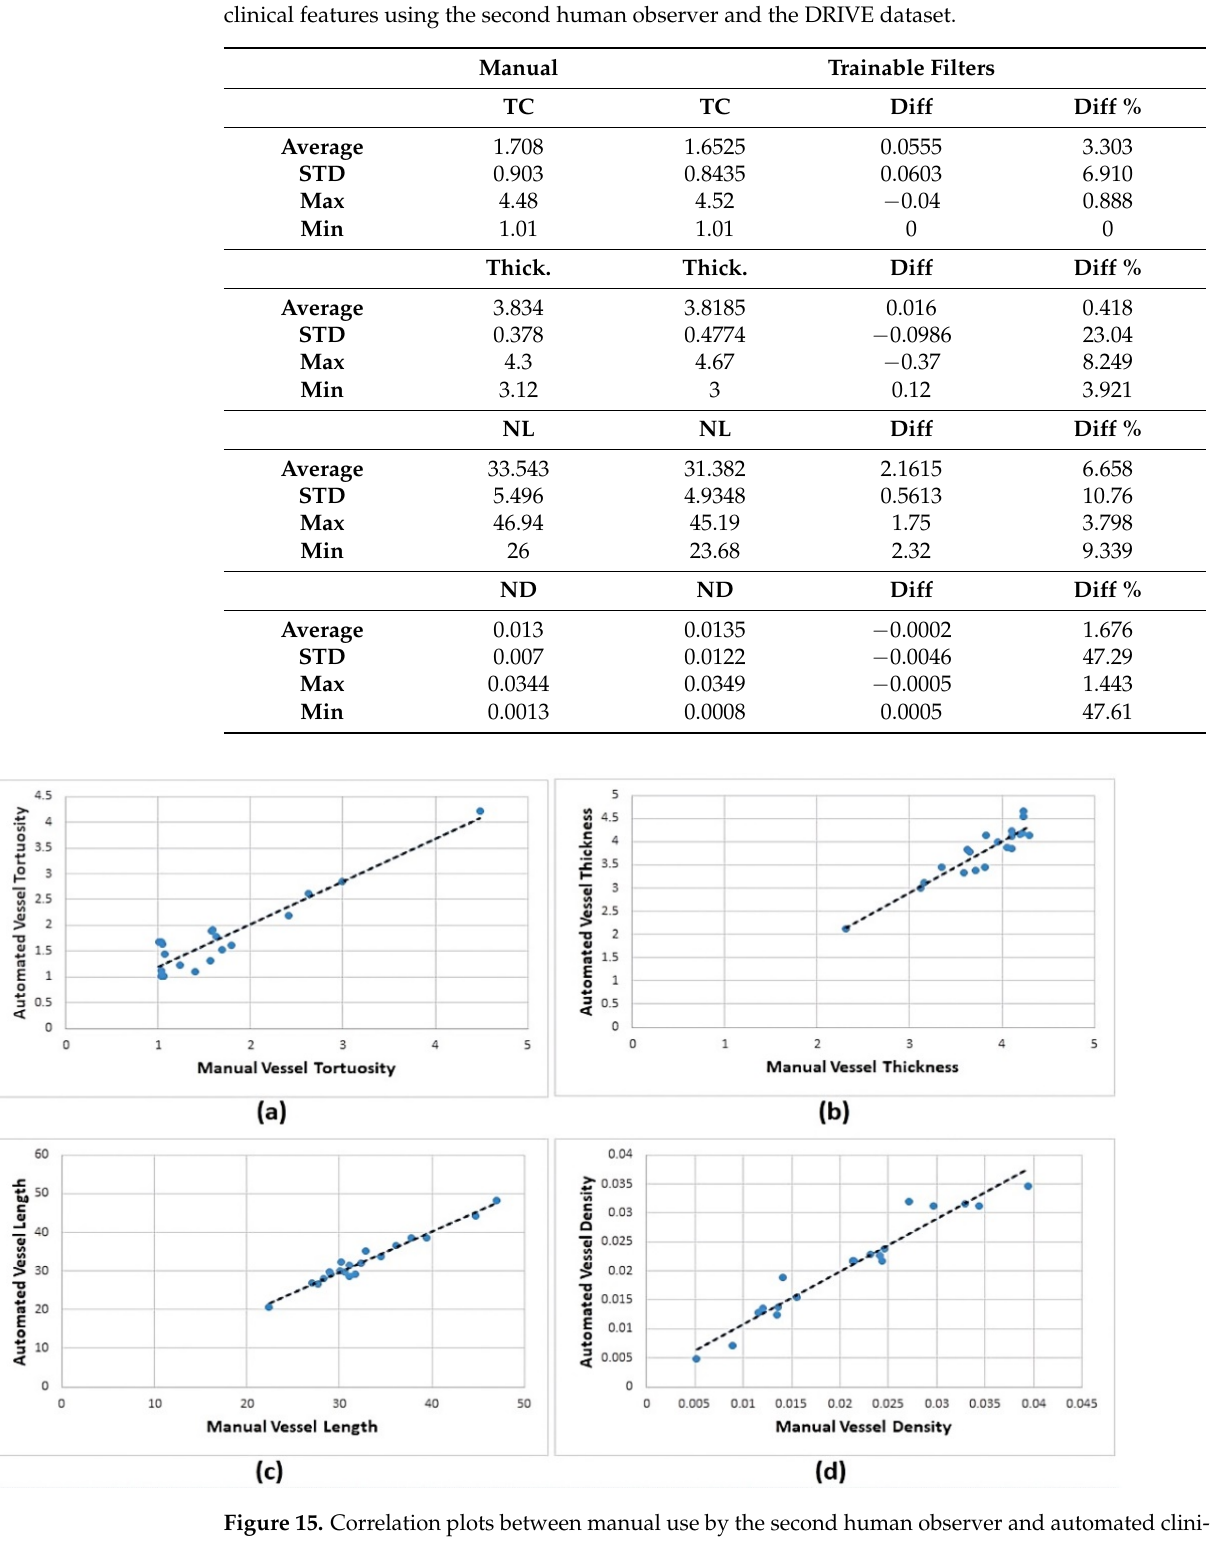
Table 6. Performance comparison conducted between the manual and automated estimations of four clinical features using the second human observer and the DRIVE dataset.